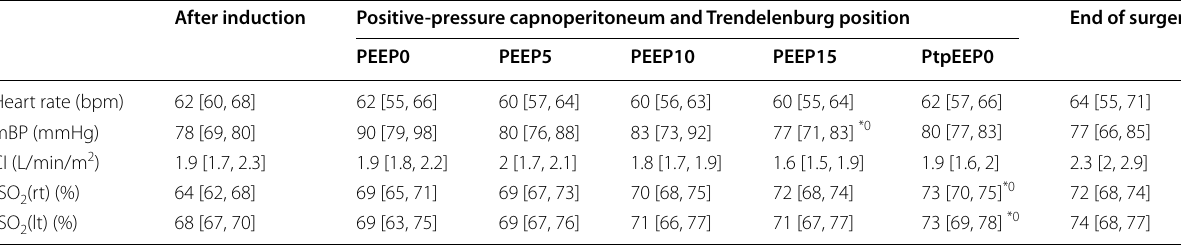
Table 4 Changes in hemodynamic and cerebral oxygenation parameters during anesthesia